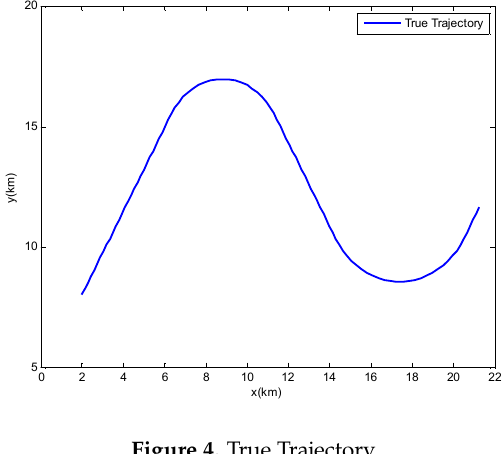
Figure 4. True Figure 4. True Trajectory.